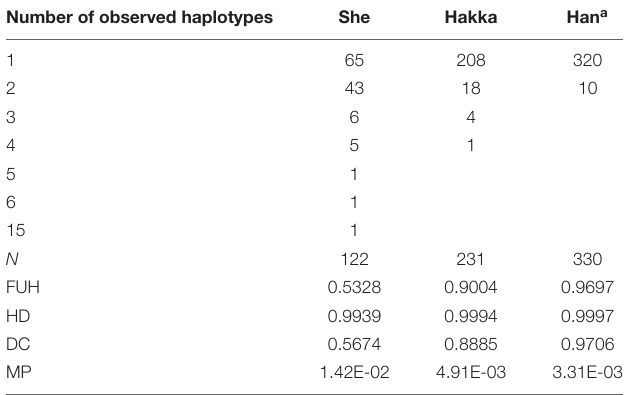
TABLE 1 | Forensic characteristics of 23 Y-STRs in Guangdong populations (Hakka, She, and Han). Number of observed